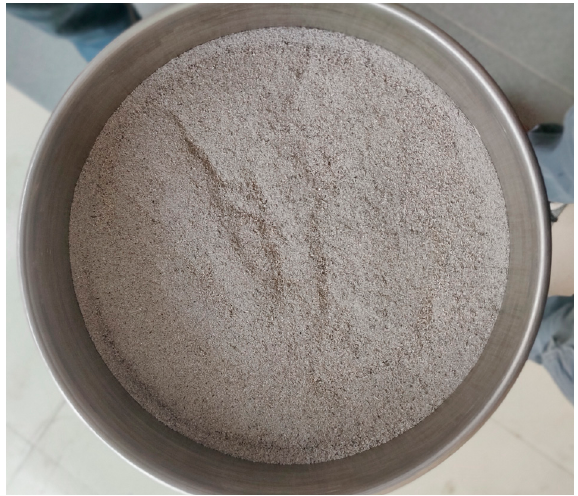
Figure 2. Sample of rice husk ash.